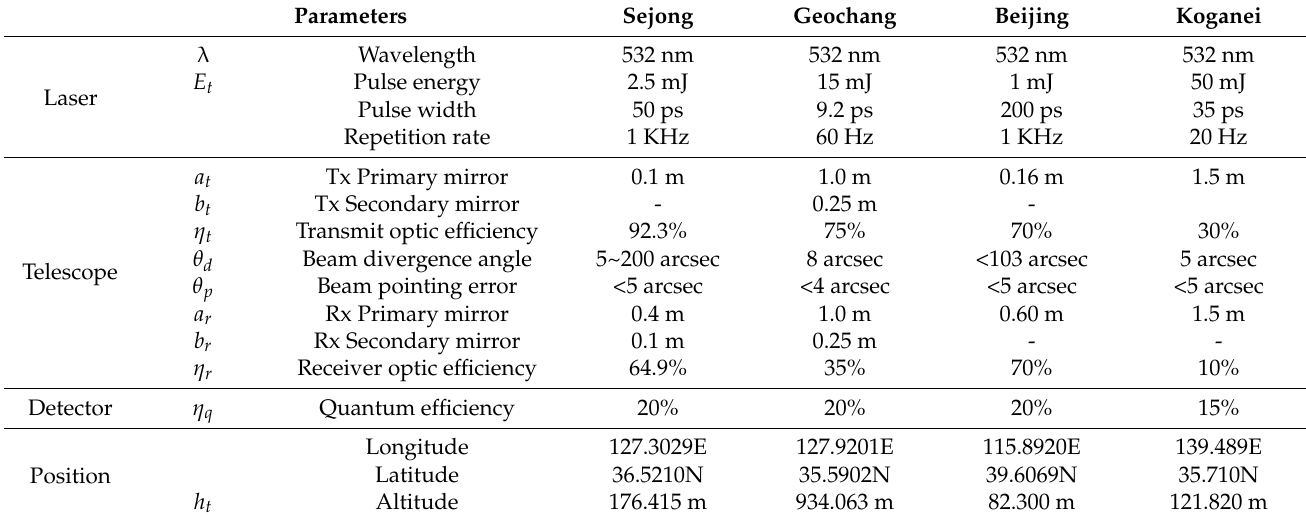
Table 2. Parameters of 4 SLR stations in the target network [18].